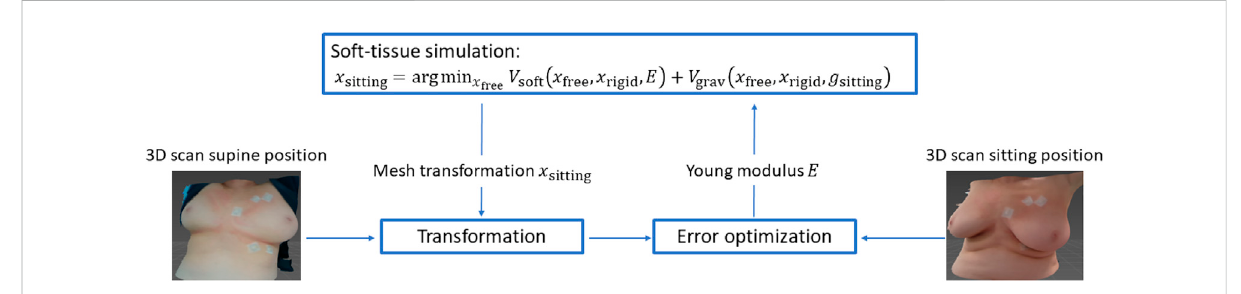
FIGURE 3 We estimate soft-tissue parameters of the breast model (i.e., its Young modulus) by solving an optimization problem. We take the boundary conditionsofthesittingcon fi gurationandwecomputethedeformationofthebreastfromsupinetosittingcon fi guration.Usingthisdeformation,we transformthesupine-position3Dscan,weregisterittothesitting-position3Dscan,andweusetheregistrationerrortofurtheroptimizethematerial